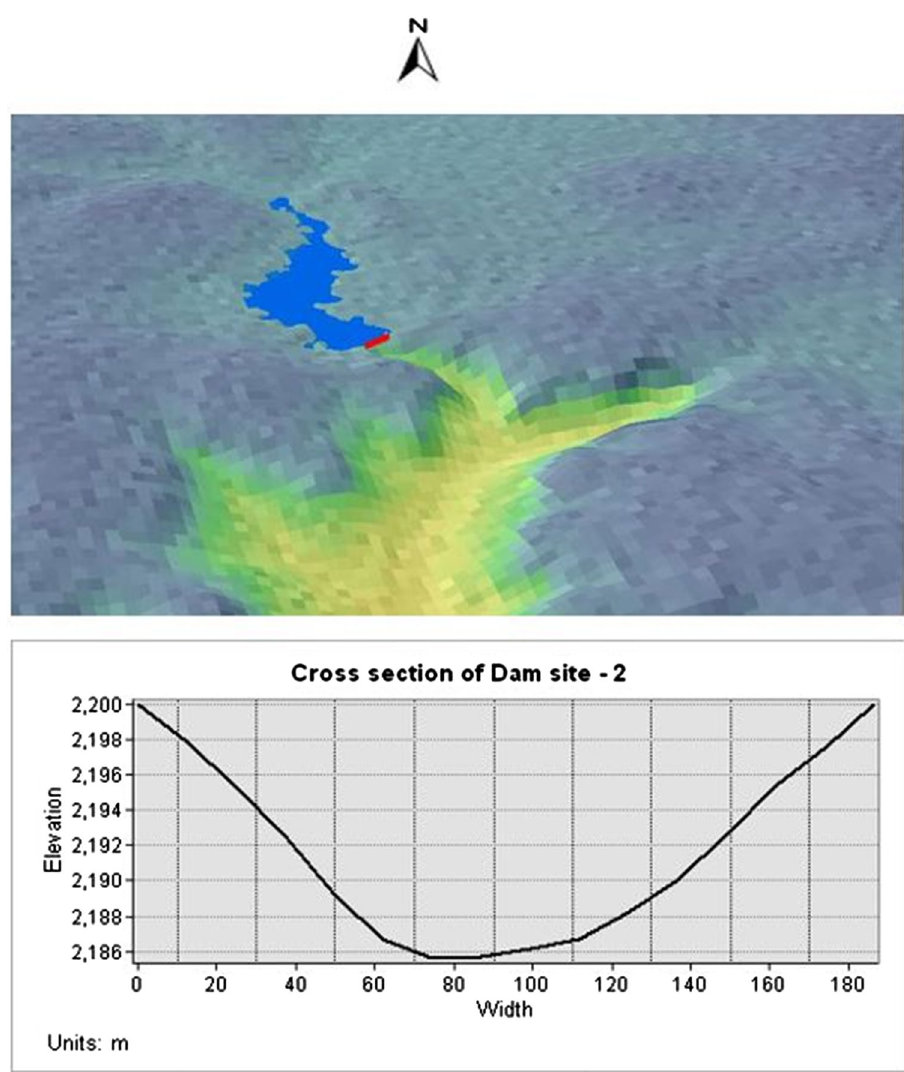
Fig. 15 3D view and cross sec- tion of proposed dam